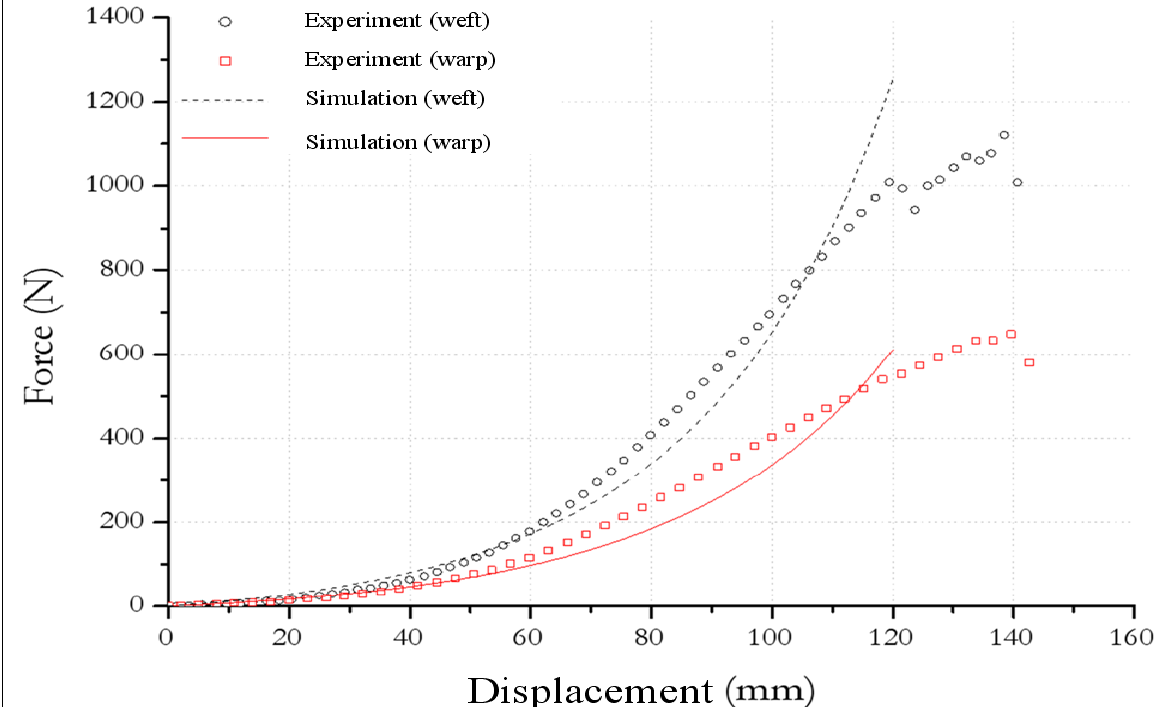
Figure 10. Tensile force versus displacement obtained from bias-extension